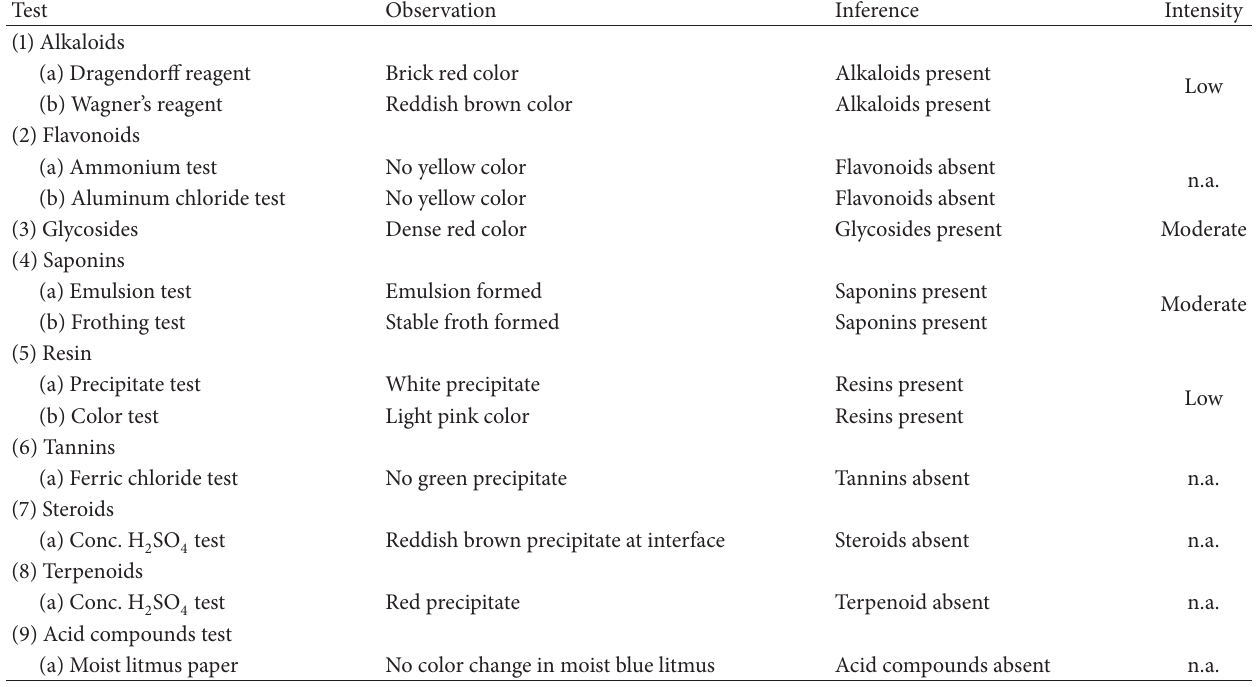
Table 5: Qualitative phytochemical analyses of coconut copra oil (commercial and by Soxhlet assembly). Test